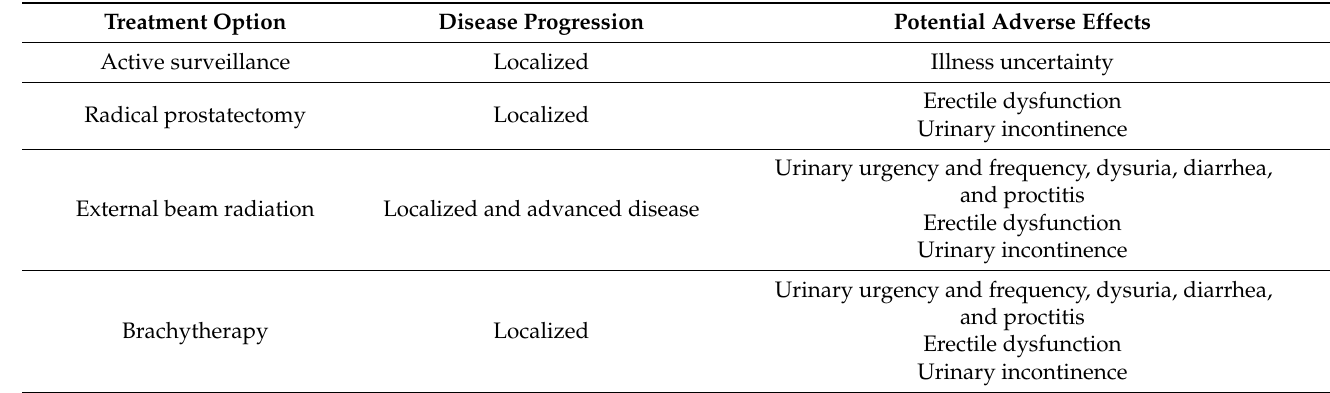
Table 4. Common prostate cancer treatment options and potential adverse effects